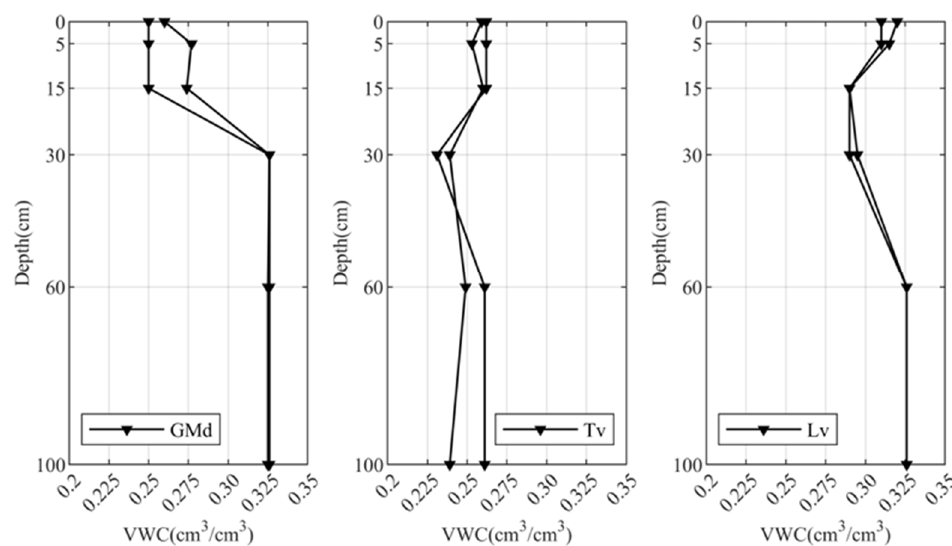
Figure 3. Profiles of soil moisture at points in GMd, Tv, and Lv sediments.